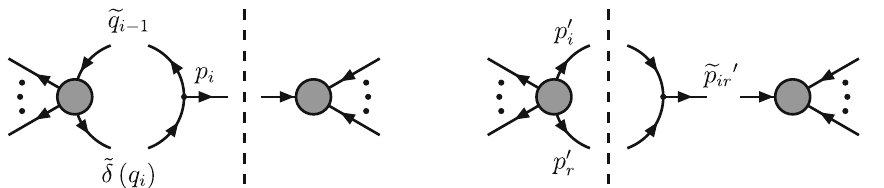
Fig. 12 Diagrammatic contributions in the collinear limit, for both the dual one-loop ( left ) and the real-emission tree-level squared amplitudes ( right ). The lines that are crossed by a dashed line correspond to on-shell states. When particles are collinear, the parent becomes on-shell and the diagrams